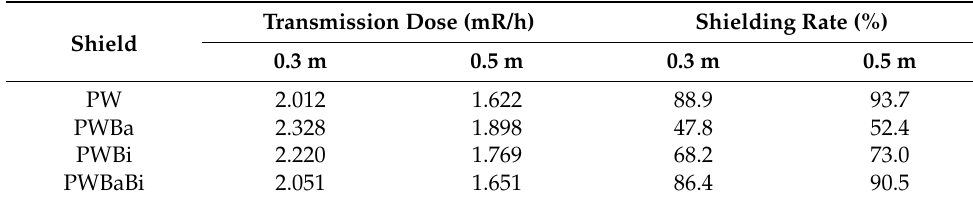
Table 2. Transmission dose and shielding rate of 99m Tc.